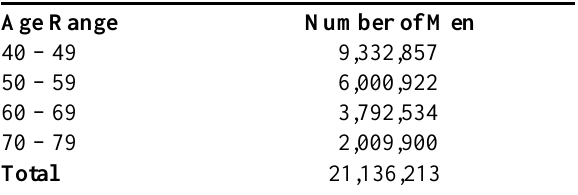
Table 3 – Population of Brazilian men, divided by age range in years.